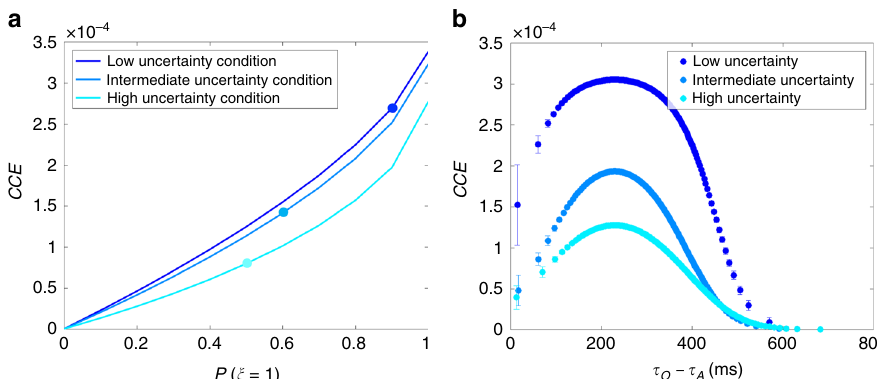
Fig. 6 Bayesian model predictions of CCE as function of the causal prior and temporal disparity τ O − τ A . a The different effects of the causal prior on CCE across the three conditions is evident even with equal causal priors, which means that CCE depends on outcome uncertainty. b When plotted as functions of the temporal disparity τ O − τ A , given the condition-dependent causal priors (marked by the colored dots in a ), CCE falls off with the disparity of sensory inputs from the prior mean, | τ O − τ A − μ AO |, faster when the outcome uncertainty